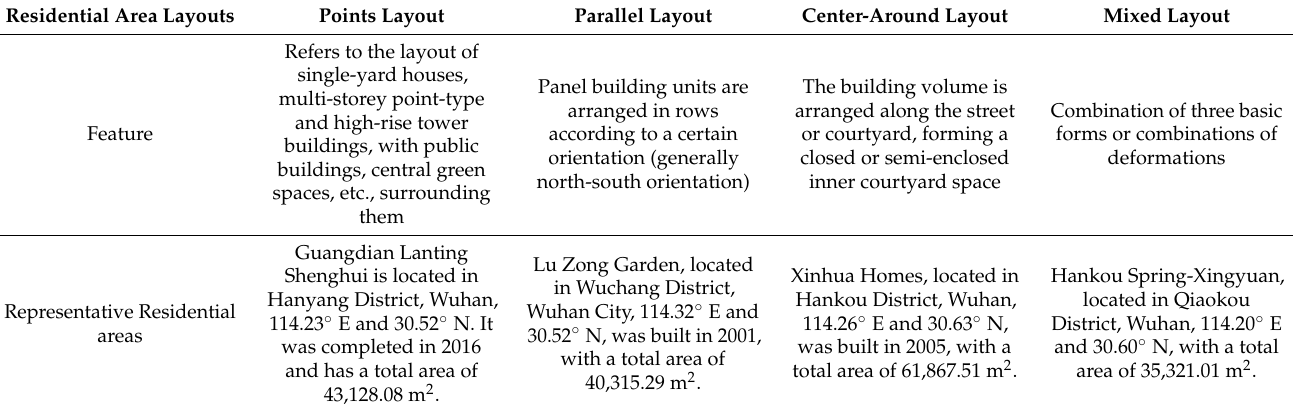
Table 1. Spatial layout characteristics of four different residential